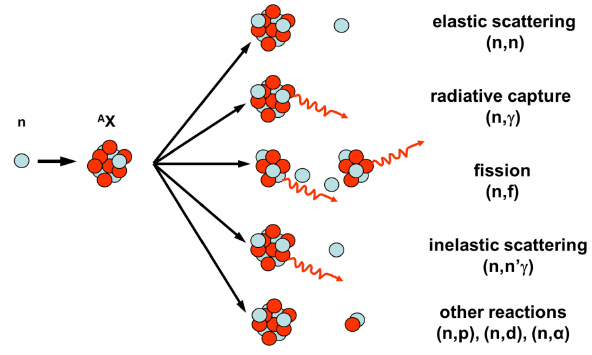
Fig. 1. Neutron-induced reactions